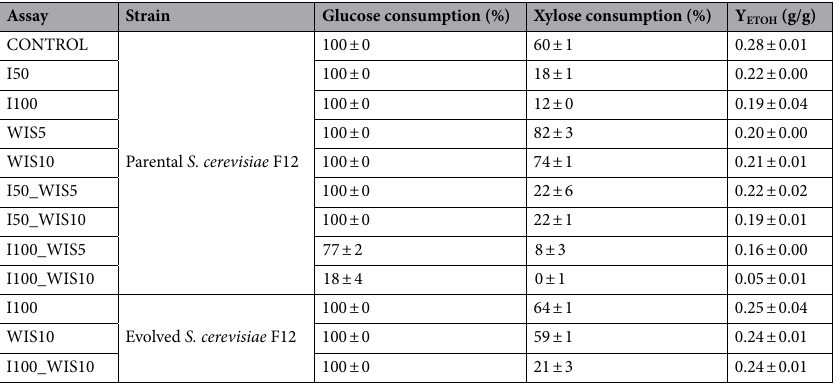
Table 3. Glucose and xylose consumption and ethanol yields during fermentation assays at different inhibitors and WIS